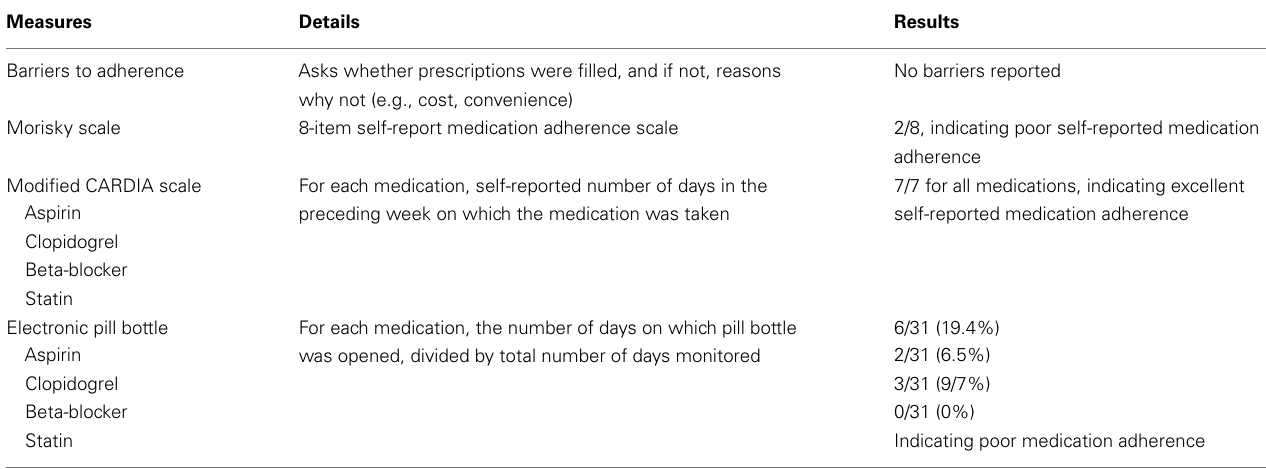
TableA1 | Outcome of medication adherence assessment for Mr.